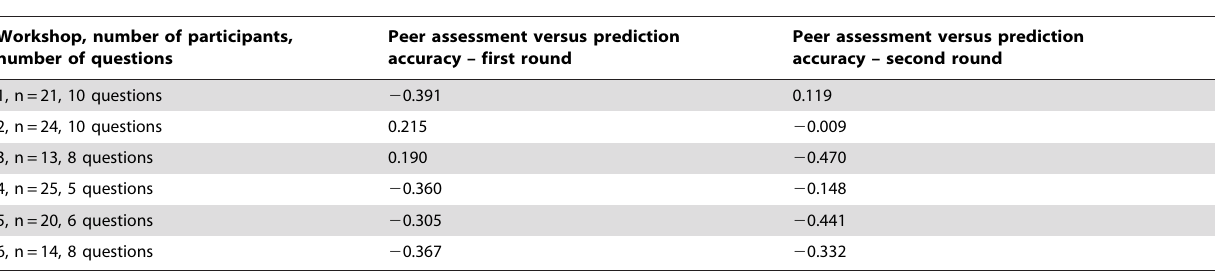
Table 3. Correlations between peer assessments of expertise and the accuracy of predictions.